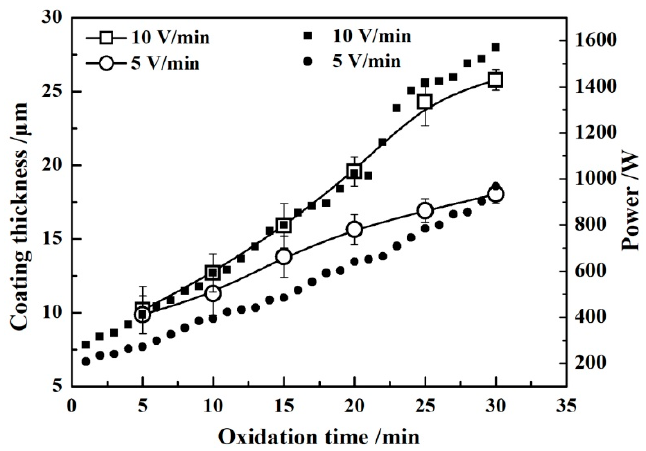
Figure 11. The thickness of MAO coatings and electric power with oxidation time at the loading level was 10 V/min and 5 V/min.